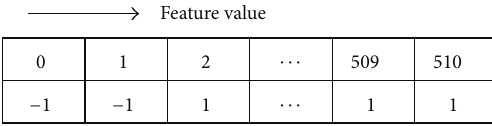
Figure 2: Example of classifier using lookup table.